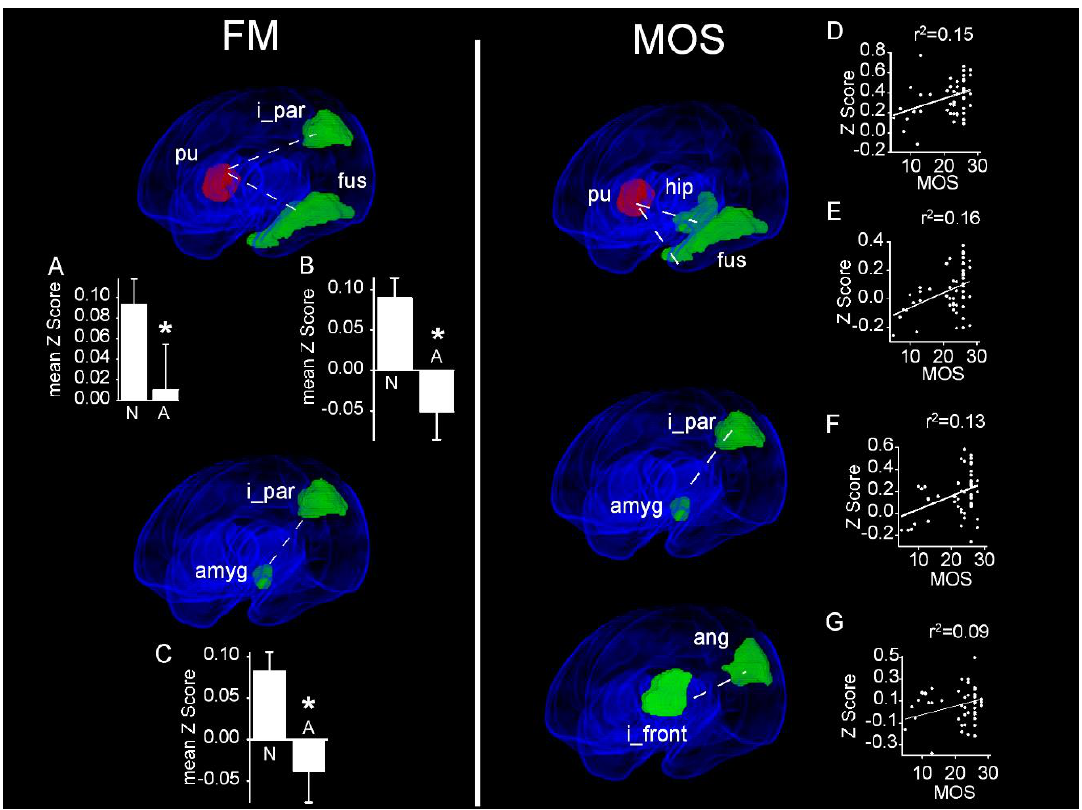
Figure 3. Altered resting state functional connectivity in infants as a function of spontaneous movement. Obliquely projected 3D reconstructions of MRI images of cerebral grey matter and identified parcellated regions derived from a neonatal atlas. FM: Brain regions pairs demonstrating an increased resting state functional connectivity (rsFC) in infants with normal FMs compared with those having aberrant FMs. Insets: Mean Fisher transformed Z-scores ± 1 SEM. ( A ) Putamen and inferior parietal cortex; ( B ) Putamen and fusiform gyrus. ( C ) Amygdala and inferior parietal cortex. MOS (motor optimality score): Brain region pairs demonstrating statistically significant main e ff ects of the MOS on rsFC. Insets: mean Fisher-transformed Z-scores of correlation coe ffi cients. ( D ) Putamen and hippocampus. ( E ) Putamen and fusiform gyrus. ( F ) Inferior parietal cortex and amygdala. ( G ) Inferior frontal gyrus and angular gyrus. Dashed white lines depict connectivity relationships. N: Normal; A: Abnormal. * P FDR <